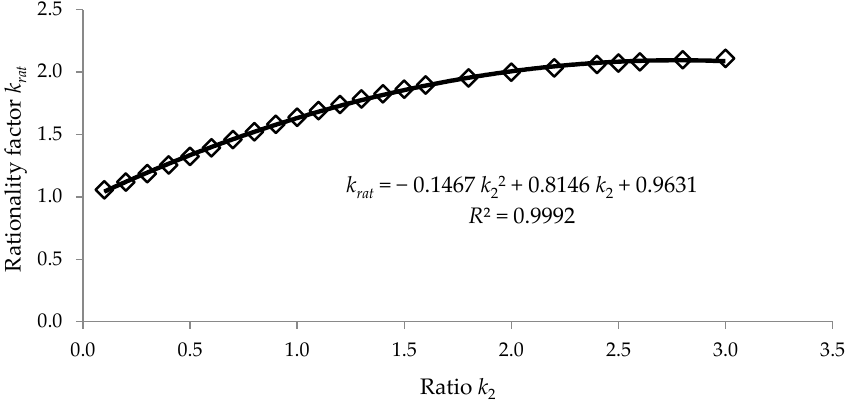
Figure 14. Variation in the rationality factor 𝑘 𝑟𝑎𝑡 computed with Equation (37) considering 𝑘 1 = 4 related to the ratio 𝑘 2 .